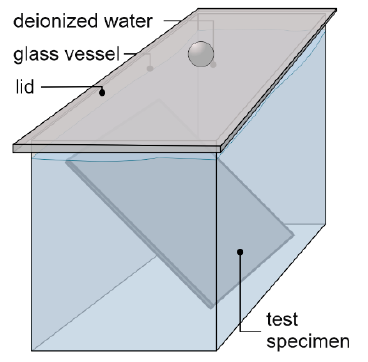
Figure 6. Schematic presentation of the dynamic surface leaching test (DSLT) setup.